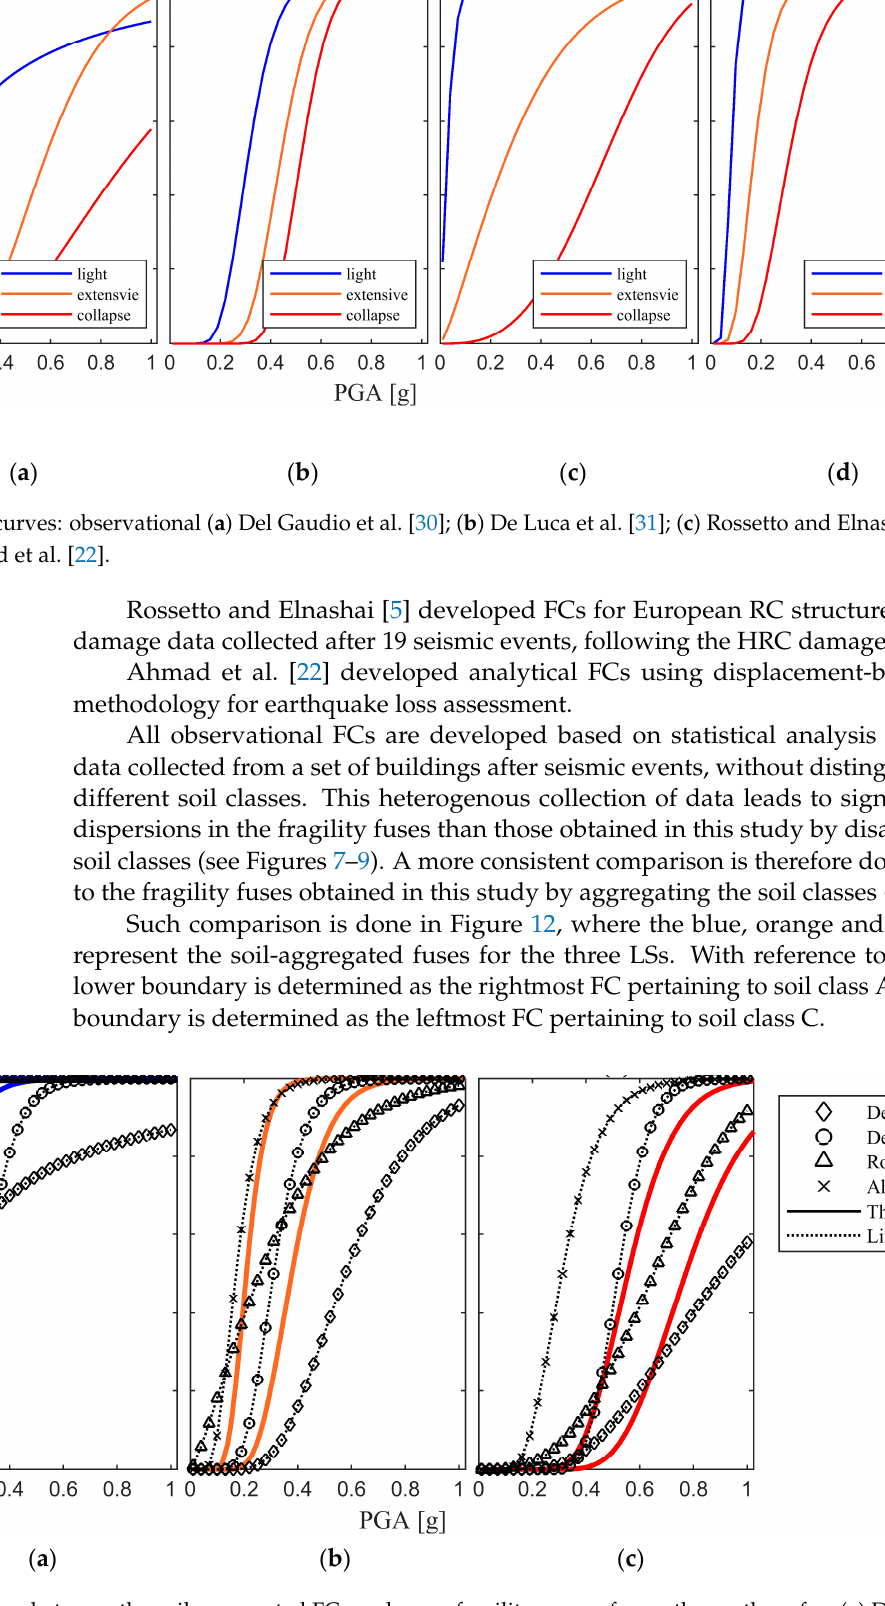
Figure 11. Comparison between the soil-aggregated FCs and some fragility curves from other authors for: ( a ) DLS; ( b ) LLS; and ( c ) CLS.